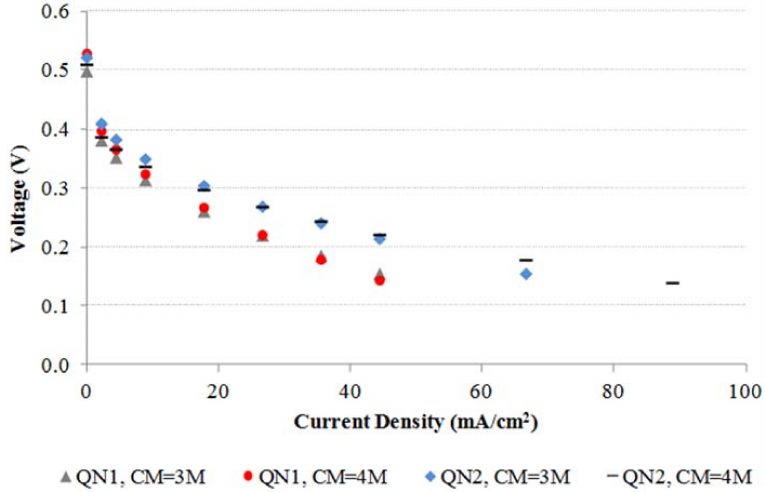
Figure 2. Voltage polarization curves comparison for MEAs QN1 and QN2 for different methanol feed concentrations (CM). Operating conditions: Temperature 25 ◦ C, Pressure 1 atm, Methanol/Air flow rates of 0.11/130 mL/min.